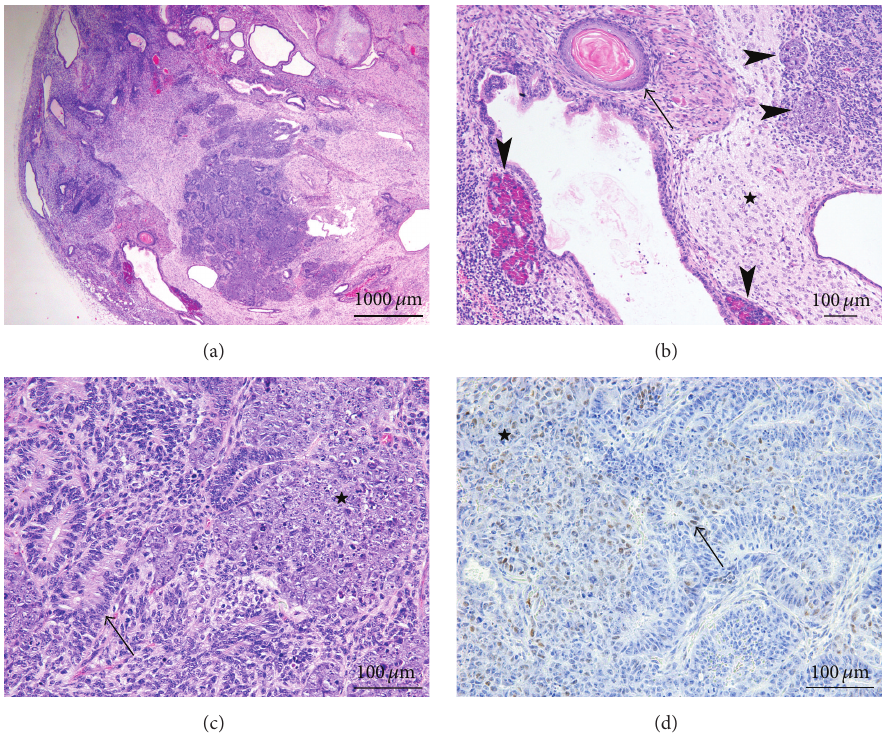
Figure 8: iPSC generated from mouse hematopoietic stem cells. Tumors produced were mainly solid mixed germ cell tumors (a, H&E 20x). The teratoma component showed derivatives from all three germ layers (b, H&E 100x), with the ectodermal (neuroglial, star ) and endodermal (squamous epithelium, arrow , and exocrine pancreas, vertical arrowheads ) derivatives being shown; small foci of embryonal carcinoma ( horizontal arrowheads ) were intermingled. At higher magnification (c, H&E 200x), the embryonal carcinoma cells formed small dispersed nests ( star ) within the teratoma component (immature neuroglial tissue, arrow ). MYC immunohistochemical reactivity was very faint and focal in the embryonal carcinoma foci (d,